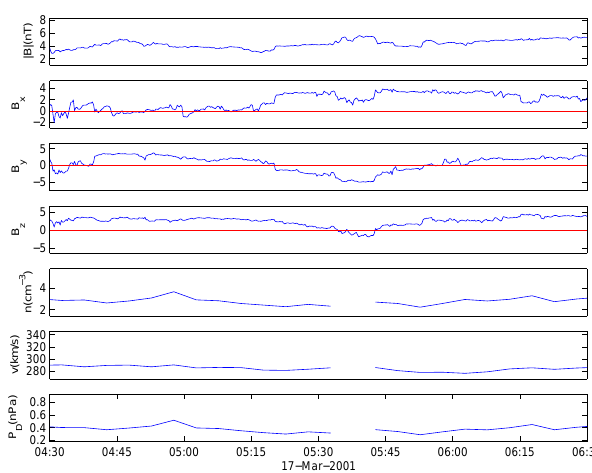
Fig. 1. Lagged (83min) solar wind data from ACE spacecraft be- tween 04:30–06:30UT at Cluster on 17 March 2001. The panels from top to bottom show solar wind magnitude, B x , B y , B z , SW proton number density, solar wind speed and solar wind dynamical